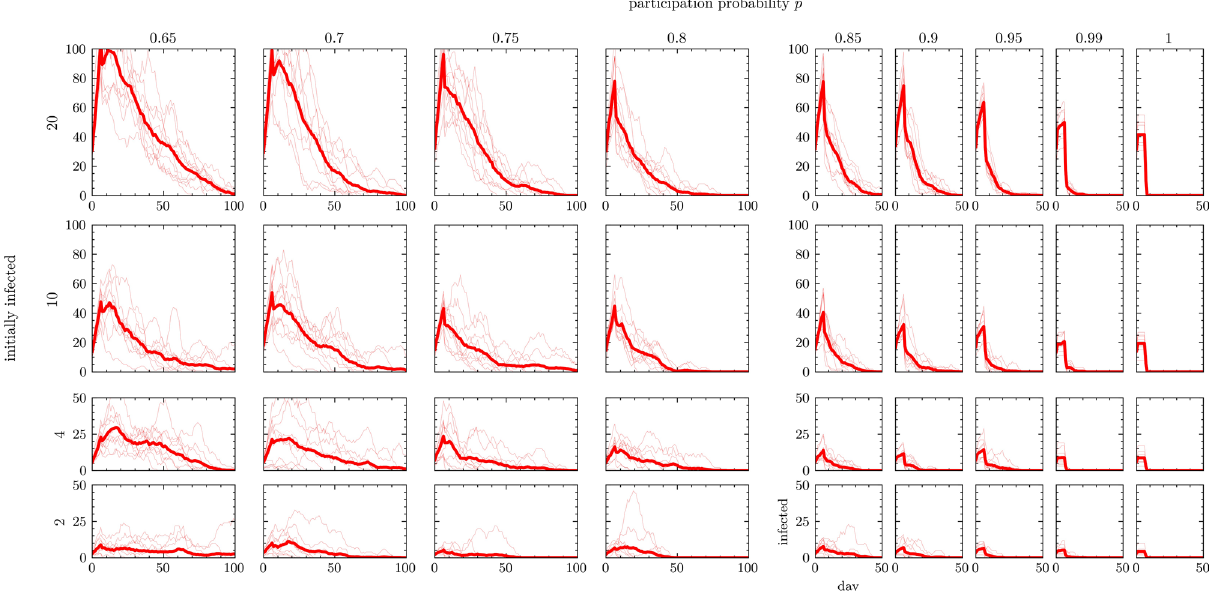
Figure 3. Number of infected travellers over the course of epidemic outbreaks, with various settings of initially infected (rows) and demand stability (columns), bold lines denote averages over all experiments (shown individually using thin lines). With an unstable demand (0.65), 20 initially infected always triggers transmission reaching at least 60 travellers (out of 2000) and lasting at least 60 days. Yet in most other configurations results are less stable and actual outbreaks strongly depends on the location of initially infected, revealing a strongly heterogeneous structure of the underlying contact network. In most cases we can observe a smooth, log-normal shape with a strong outbreak in the first phase, exponentially decaying in the latter phases. Mean temporal profiles of outbreaks are consistently following the trend of decreasing when the number of initial infections is lower and a demand pattern becomes more stable . For stable demand patterns, we can observe that the number of infected drops when initially infected quarantine, followed by a smooth transmission in the second phase when demand still fluctuates ( p = 0.85 ) or halted immediately ( p > 0.95 ) . Typically, stabilising